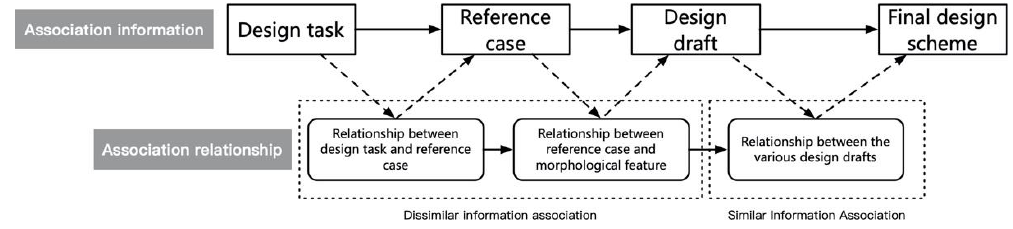
Figure 1. Association of information in product styling design process.